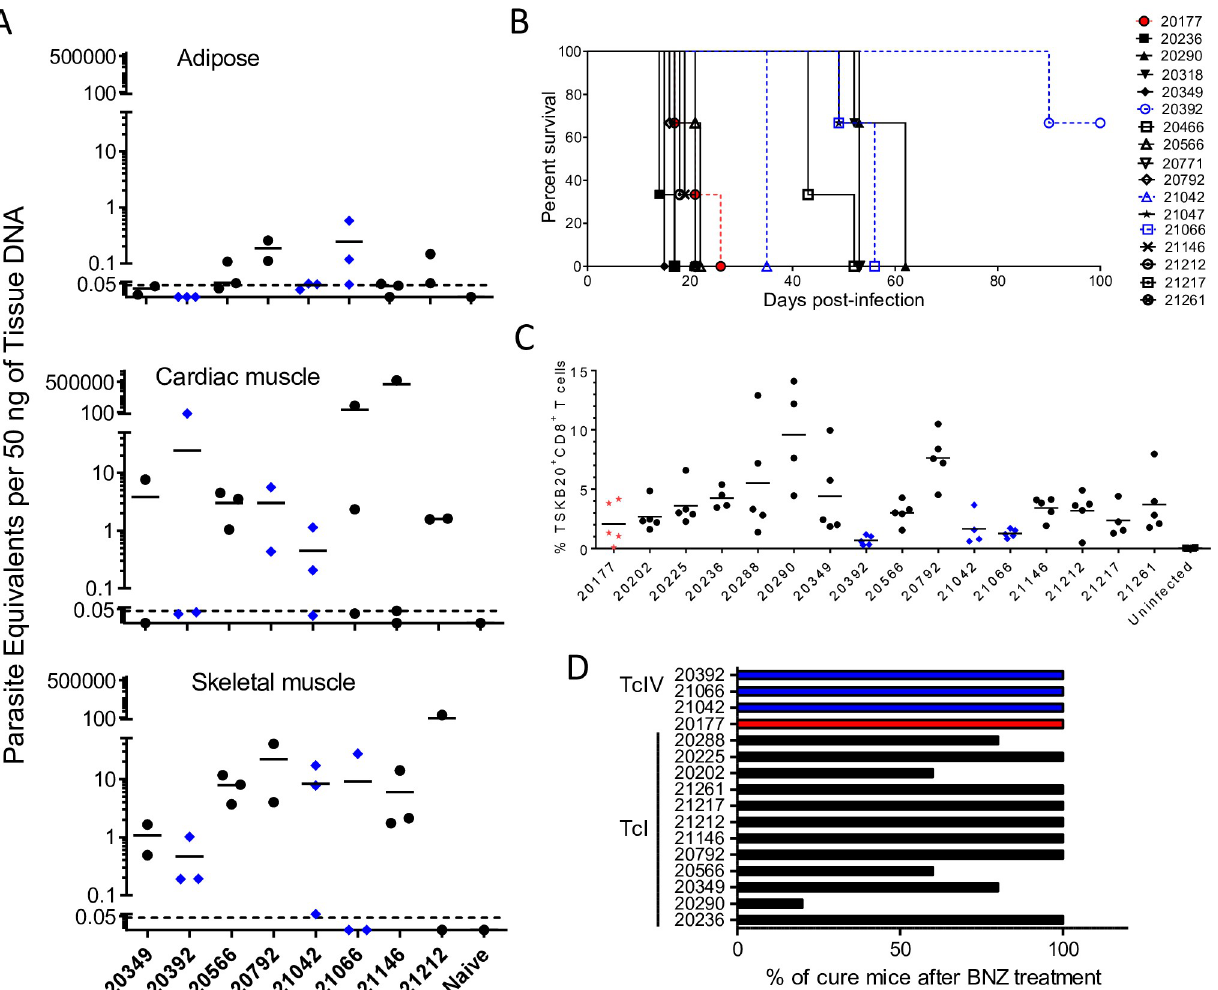
Fig 7. T . cruzi isolates from macaques display a wide phenotypic variation in mice. (A) T . cruzi DNA detection in tissues of C57BL/6 mice infected per os (p.o.) with 10 6 metacyclic trypomastigotes from 8 macaque isolates at 120–150 days post-infection. (B) Survival curve of IFNg-KO mice infected intraperitoneally with 10 6 metacyclic trypomastigotes from macaque T . cruzi isolates (n = 3 mice per isolate). (C) Frequency of CD8 + T cells in blood specific for the immunodominant T . cruzi -TSKb20 epitope in C57BL/6 mice orally infected with macaque isolates. (D) Percentage of infected C57BL/6 mice cured after benznidazole treatment, determined by qPCR of skeletal muscle following immunosuppression (n = 4–5 per isolate). DTU: TcI (black), TcIV (blue), or TcI+TcIV